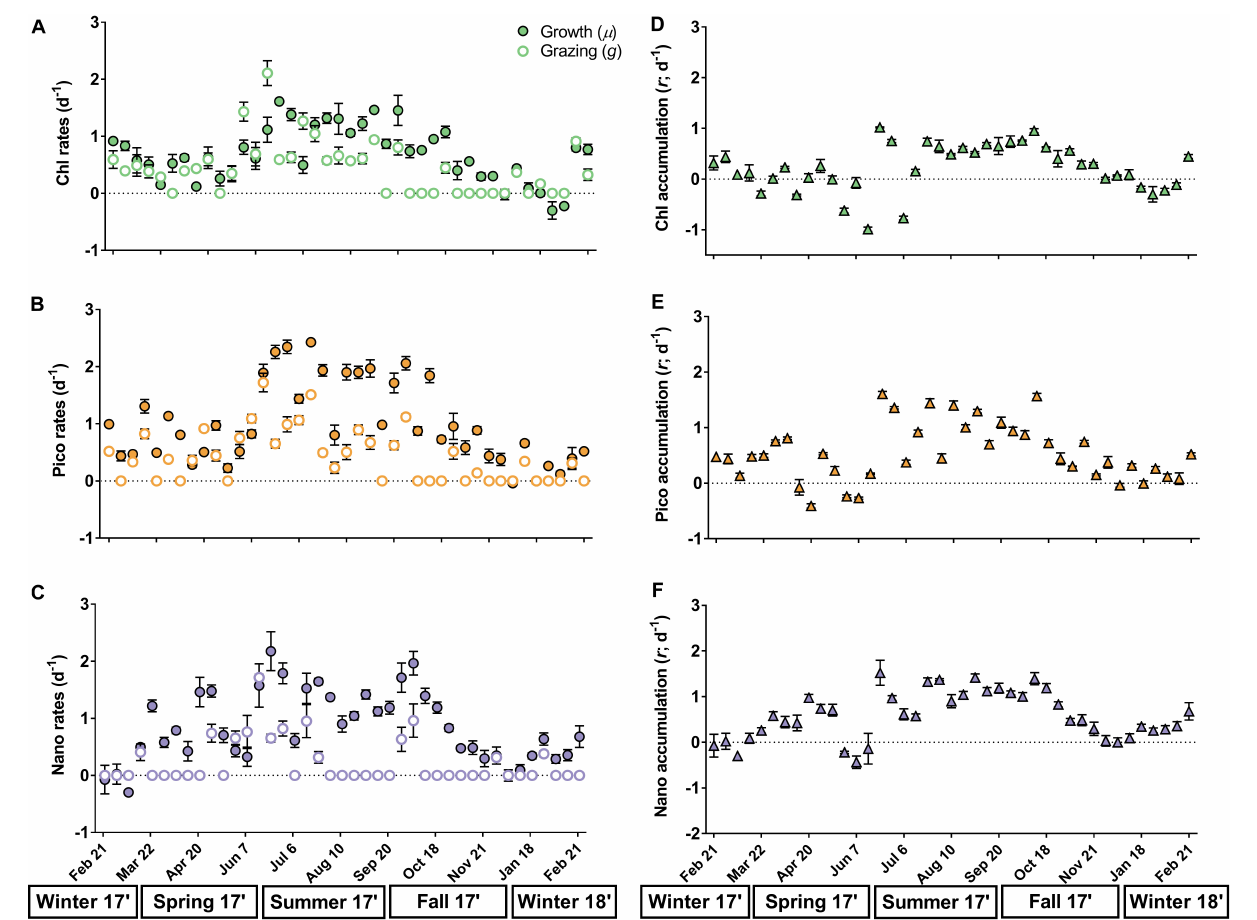
FIGURE 3 | Rates (day − 1 ) of instantaneous phytoplankton growth ( µ ; open circles), microzooplankton grazing (g ; closed circles), and net accumulation ( r ; closed triangles) measured each week based on total chlorophyll ( A,D ; green), picoeukaryotes ( B,E ; orange), and nanoeukaryotes ( C,F ; purple). Seasons are shown below the x -axis. Error bars represent one standard deviation of the mean and small error is contained within symbols. Grazing rates equal to zero (dotted line) were not significant from zero ( p <